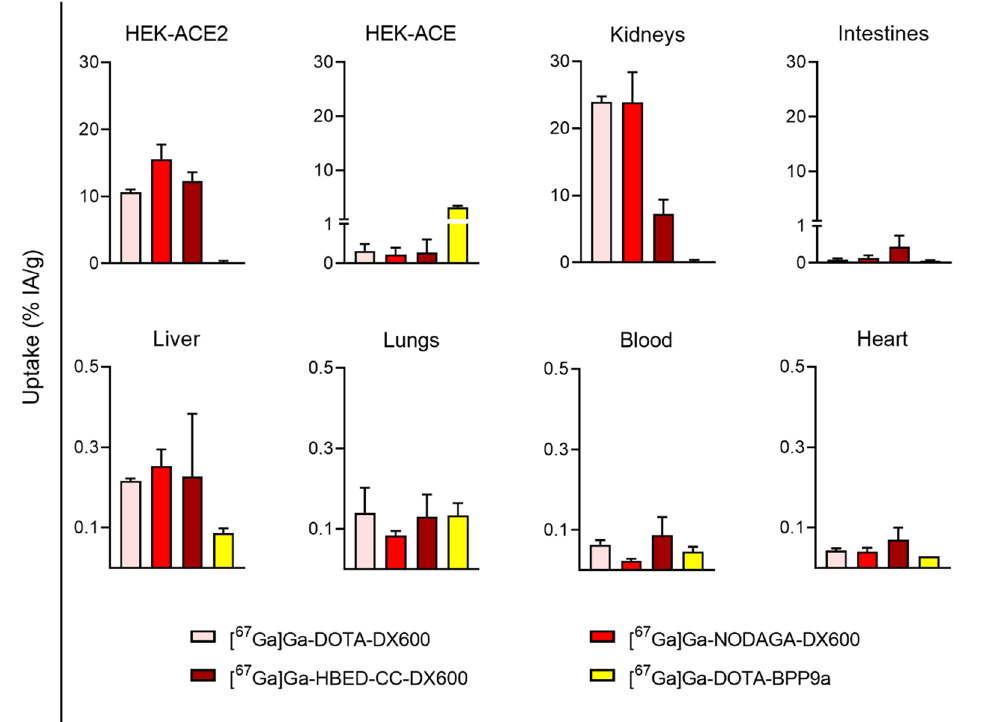
Fig. 6 Biodistribution data of [ 67 Ga]Ga‑DOTA‑DX600, [ 67 Ga]Ga‑NODAGA‑DX600, [ 67 Ga]Ga‑HBED‑CC‑DX600 and [ 67 Ga]Ga‑DOTA‑BPP9a in selected organs obtained at 3 h after injection into HEK‑ACE2/ACE xenograft‑bearing mice (average